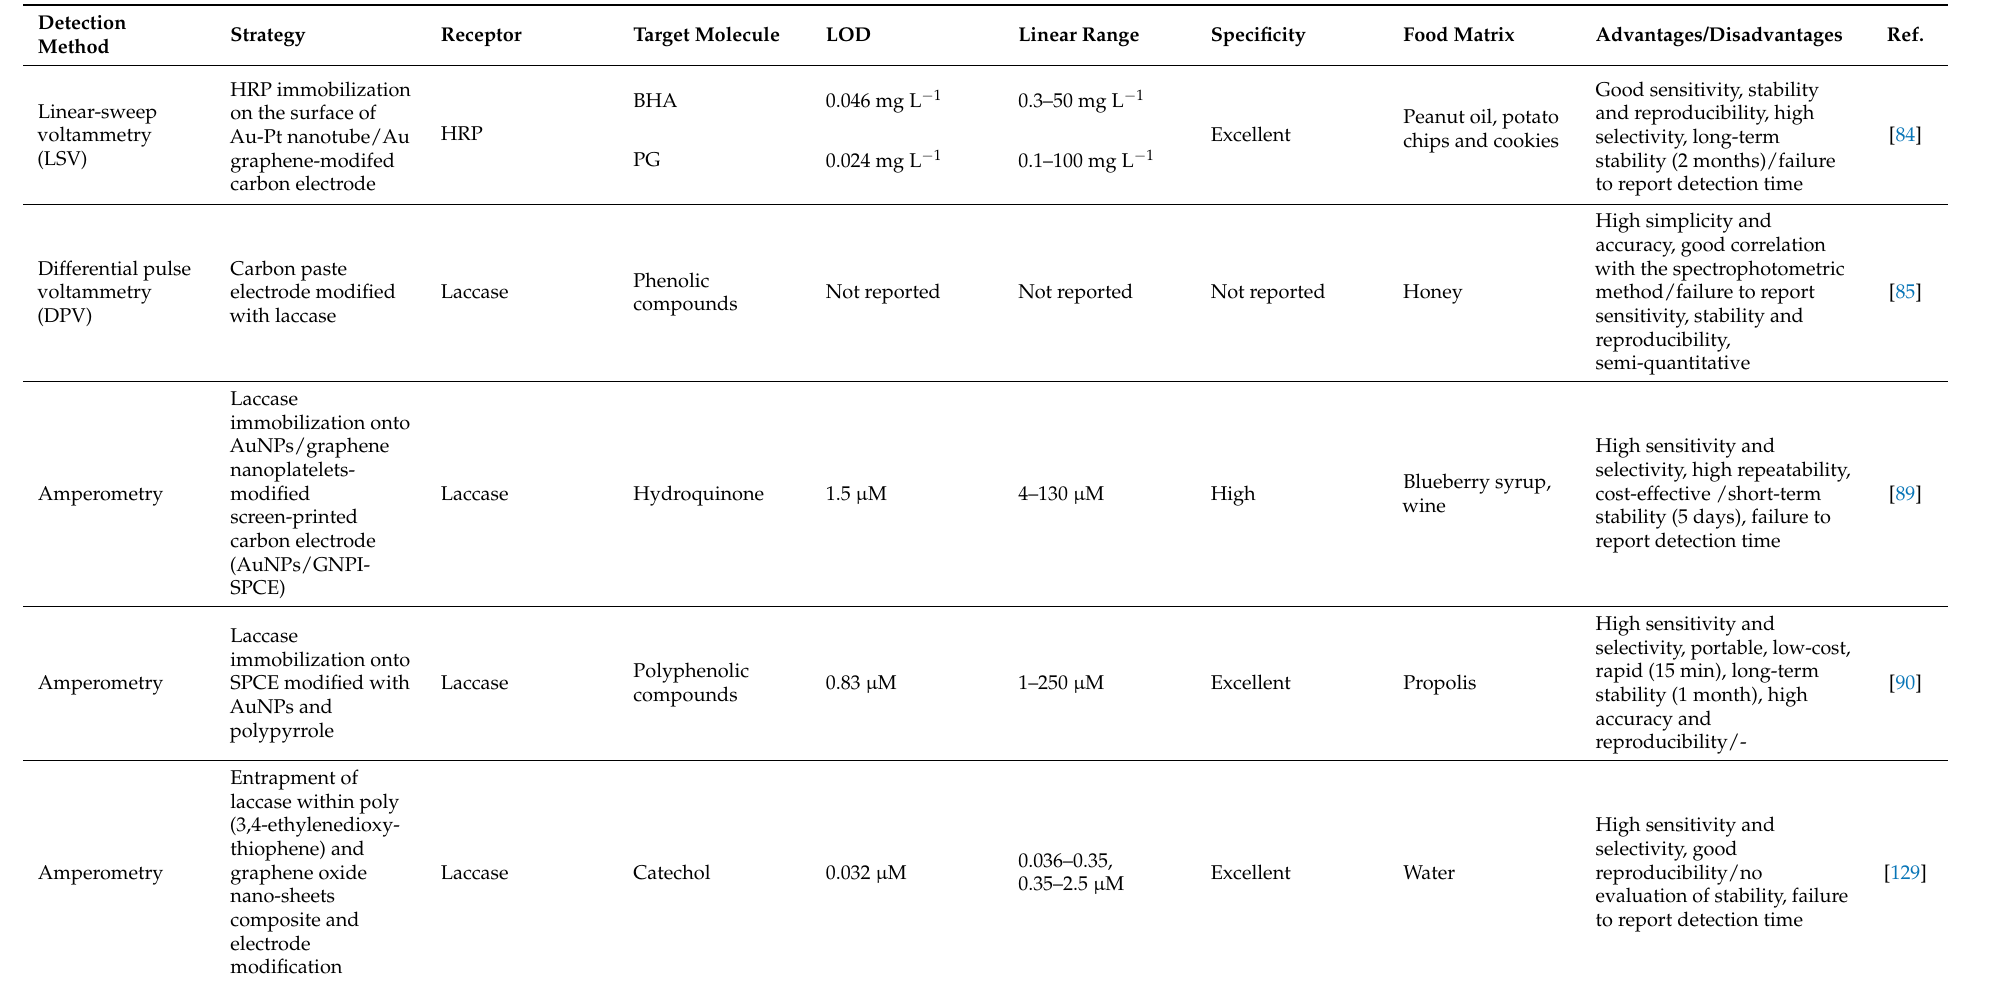
Table 3. Representative examples of recent developed electrochemical biosensors for the determination of antioxidants in food samples. Detection